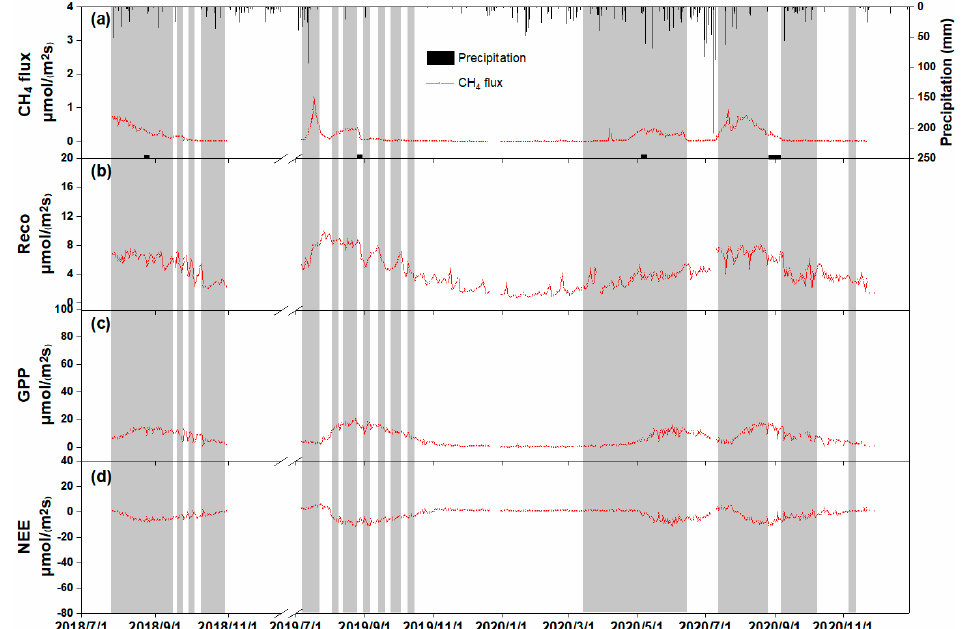
Figure 5. Seasonal variations of ( a ) CH 4 flux, ( b ) ecosystem respiration (R eco ), ( c ) GPP, and ( d ) net ecosystem exchange (NEE) during flooded (gray shaded area) and non-flooded (non-shaded area) periods. Black rectangles indicate periods of mid-season drainage in each season.